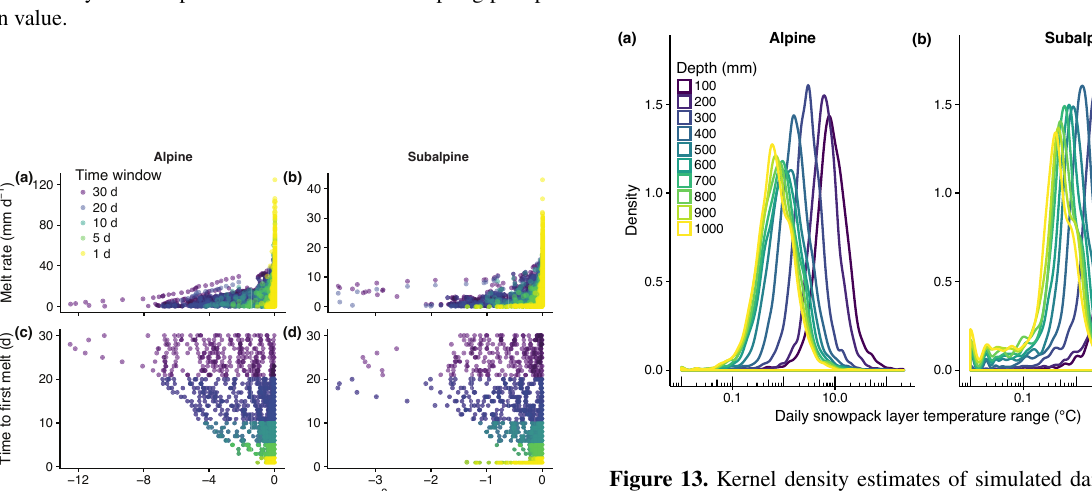
Figure 13. Kernel density estimates of simulated daily snowpack layer temperature ranges in the alpine (a) and subalpine (b) . Line shading represents the bottom depth of the layer with layers near the top of the snowpack in purple and blue and lower layers in green and